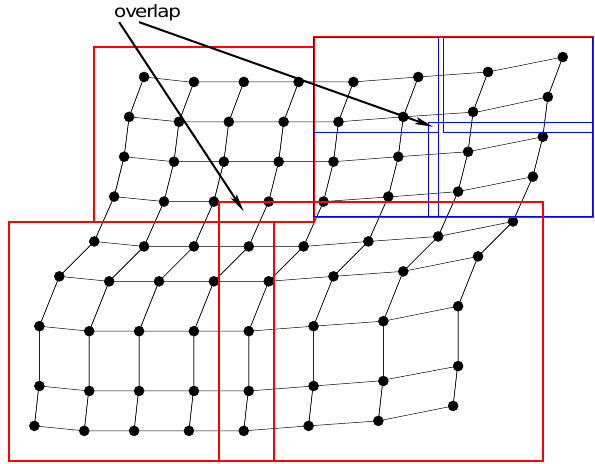
Fig. 2. Sketch of a multi-grid hierarchy for a local domain. Typi- cally the number of cells is much higher and the PSMILe will con- struct o(10)